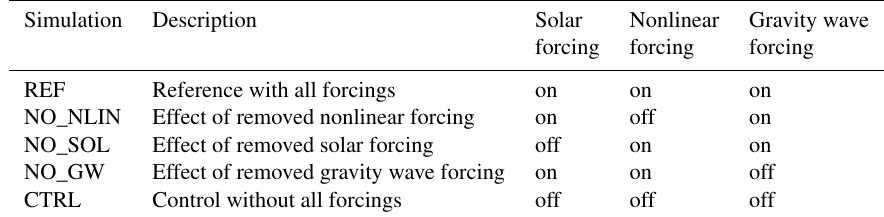
Figure 1. (a, d) REF zonal mean temperature, (b, e) zonal wind, and (c, f) meridional wind. (a–c) Solstice (January) conditions. (d–f) Equinox (April) conditions. Results are an average of the 11 ensemble members (color shading). Standard deviations σ are added as black contour lines and intervals (cid:49)σ are given in each panel. Table 1. Overview on the different simulations. Simulation Description